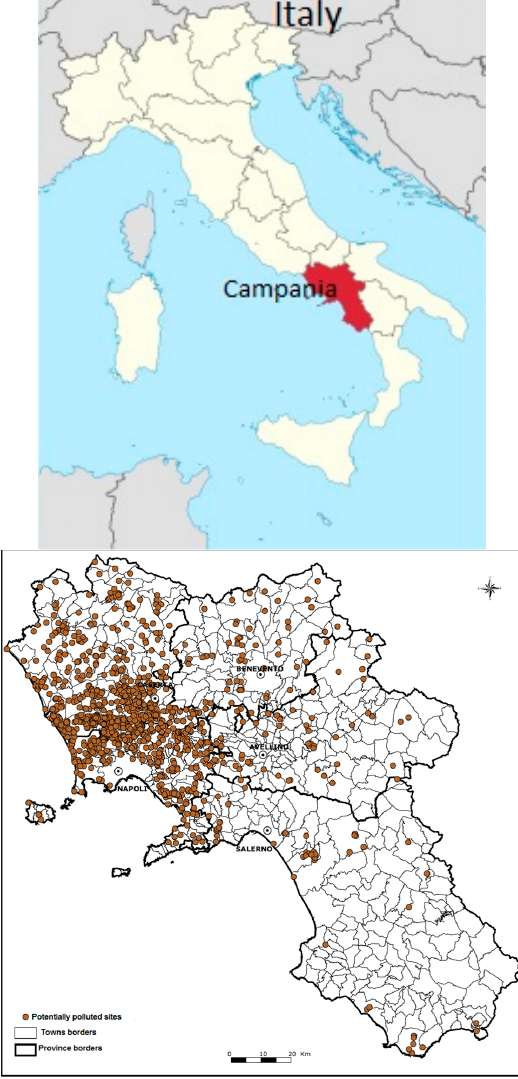
Figure 1. Map of illegal waste dumping sites in the region of Campania, Italy. Data from